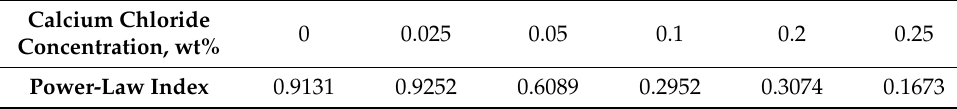
Table 2. Calculated value of n from the power-law model.